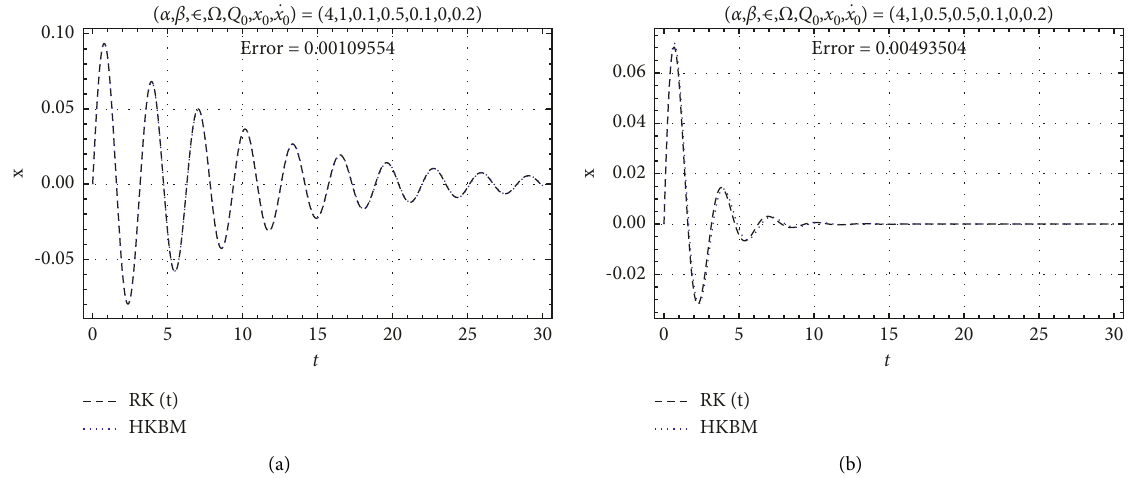
Figure 7: Both HKBM first-order approximate solution (42) and RK numerical simulation are plotted against different values of the damping parameter ε